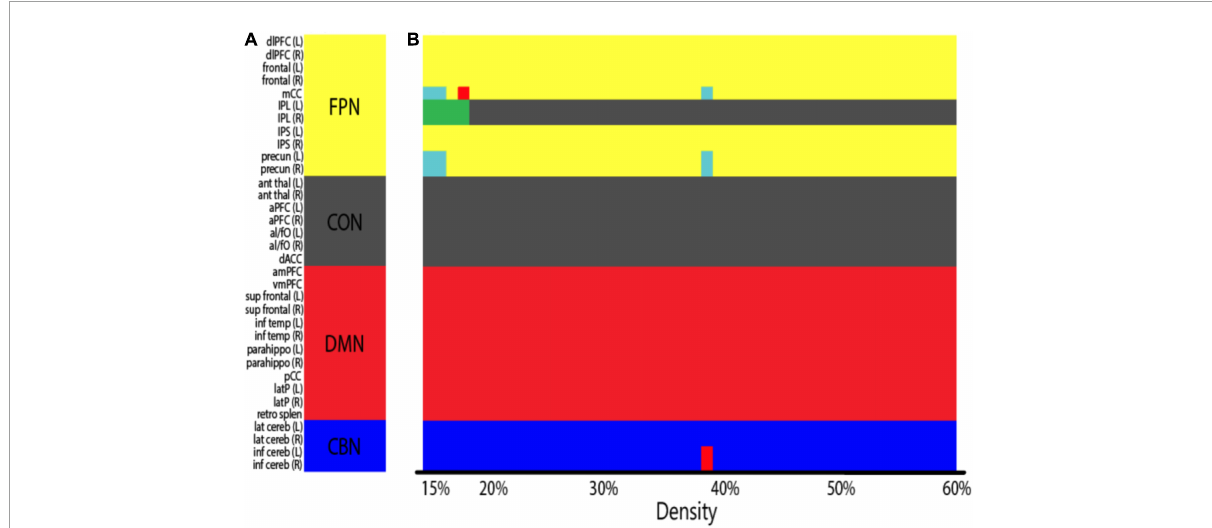
FIGURE2 (A) Predefined ROI network membership ( Table 3 ; FPN, fronto-parietal network; CON, cingulo-opercular network; DMN, default mode network; CBN, cerebellar network). Nodes are colored by network membership. (B) Network organization of all subjects aggregated (both the training and the control groups averaged) as identified by the modularity analysis. X -axis indicates network densities. At each density, nodes that were grouped together are coded by the same color. A few nodes were not grouped into one of the four predefined networks at low densities (light blue and green). Overall, subjects showed a similar network organization to the predefined ROI network membership across network densities.